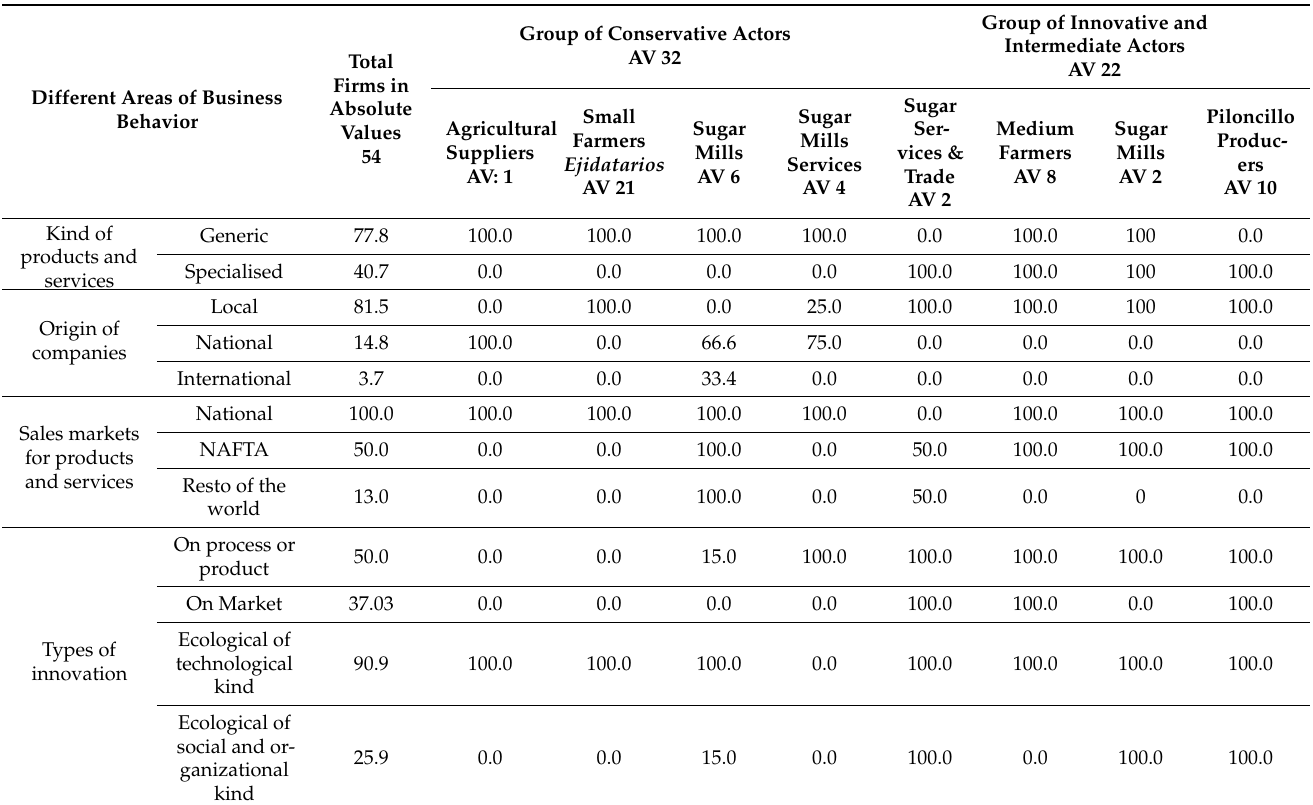
Table 1. Business behavior according to subsectors of the value chain in the conservative and transformative networks (results expressed in